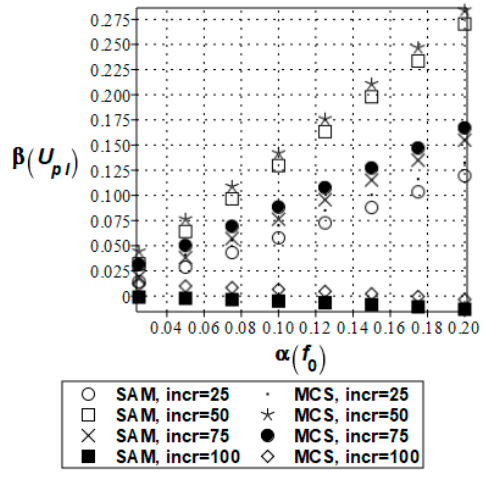
Figure 10. Skewness of plastic energy fluctuations.